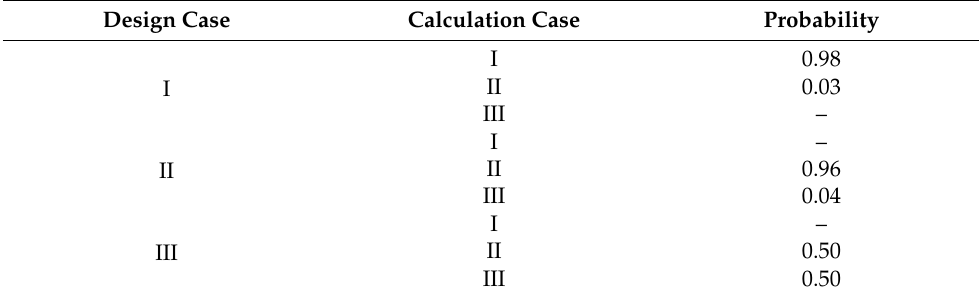
Table 5. The probability of calculation